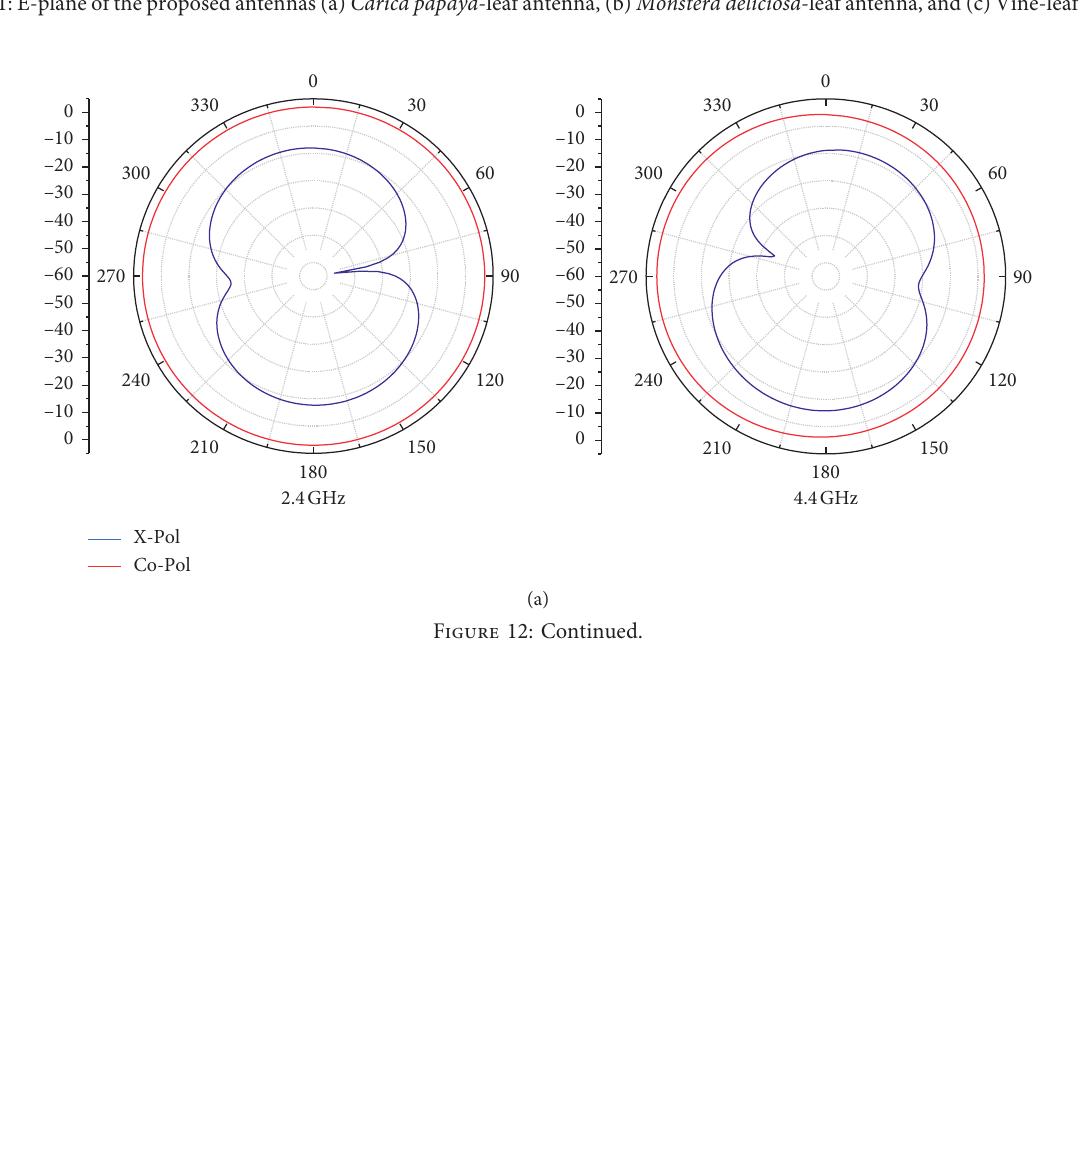
Figure 11: E-plane of the proposed antennas (a) Carica papaya -leaf antenna, (b) Monstera deliciosa -leaf antenna, and (c) Vine-leaf